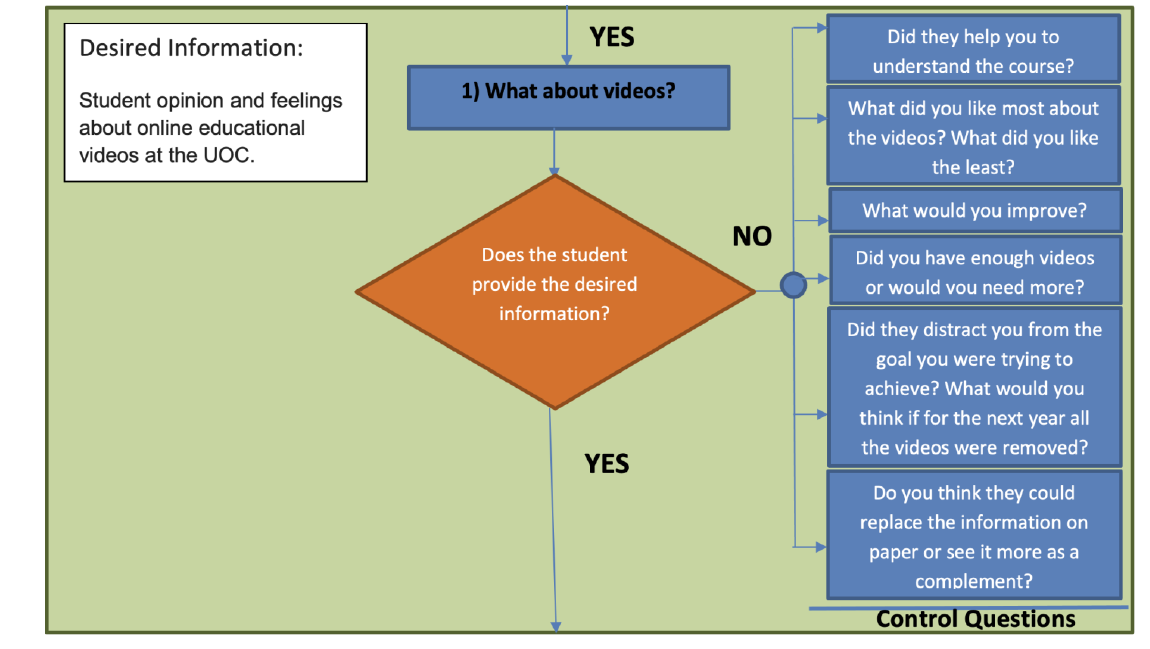
Appl. Sci. 2021 , 11 , x FOR PEER REVIEW